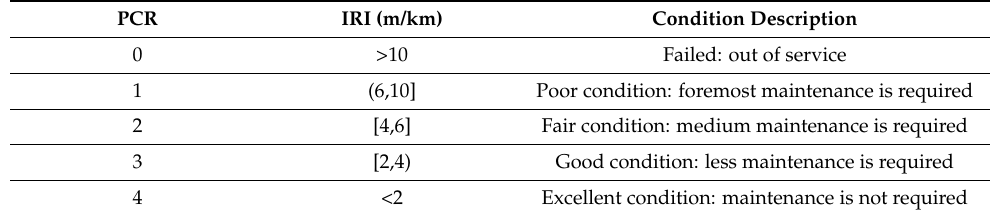
Table 1. Pavement condition rating for